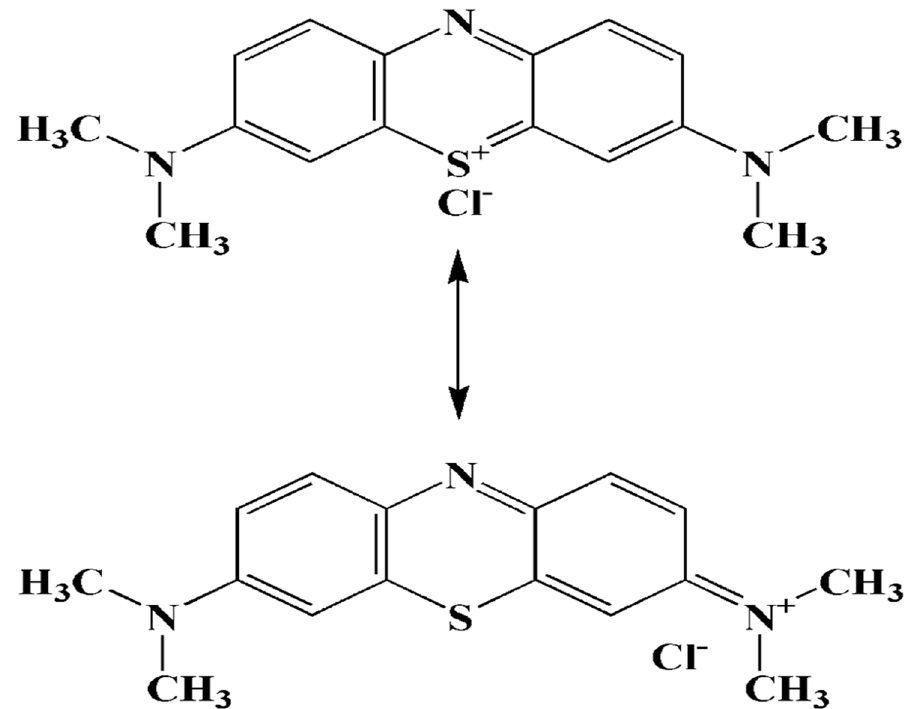
Figure 3. Different resonance structures of MB.